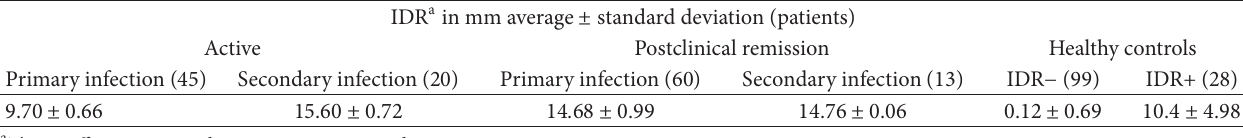
Table 4: Intradermic reaction with polyvalent amastigotes leishmanine,in patients with cutaneous leishmaniasis after spontaneous remission of lesions.